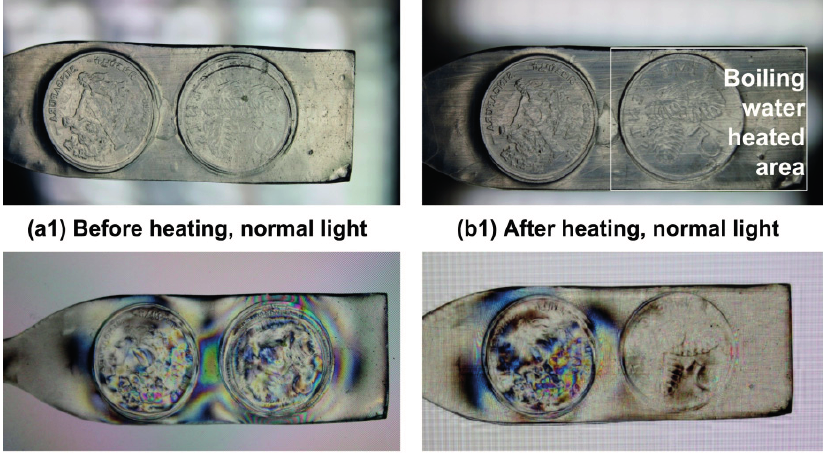
Figure 11. Monitoring shape recovery in EVA, based on photo-elasticity. ( a1 , a2 ) before heating; ( b1 , b2 ) after heating the right half of sample in boiling water. (1): normal light; (2): polarized